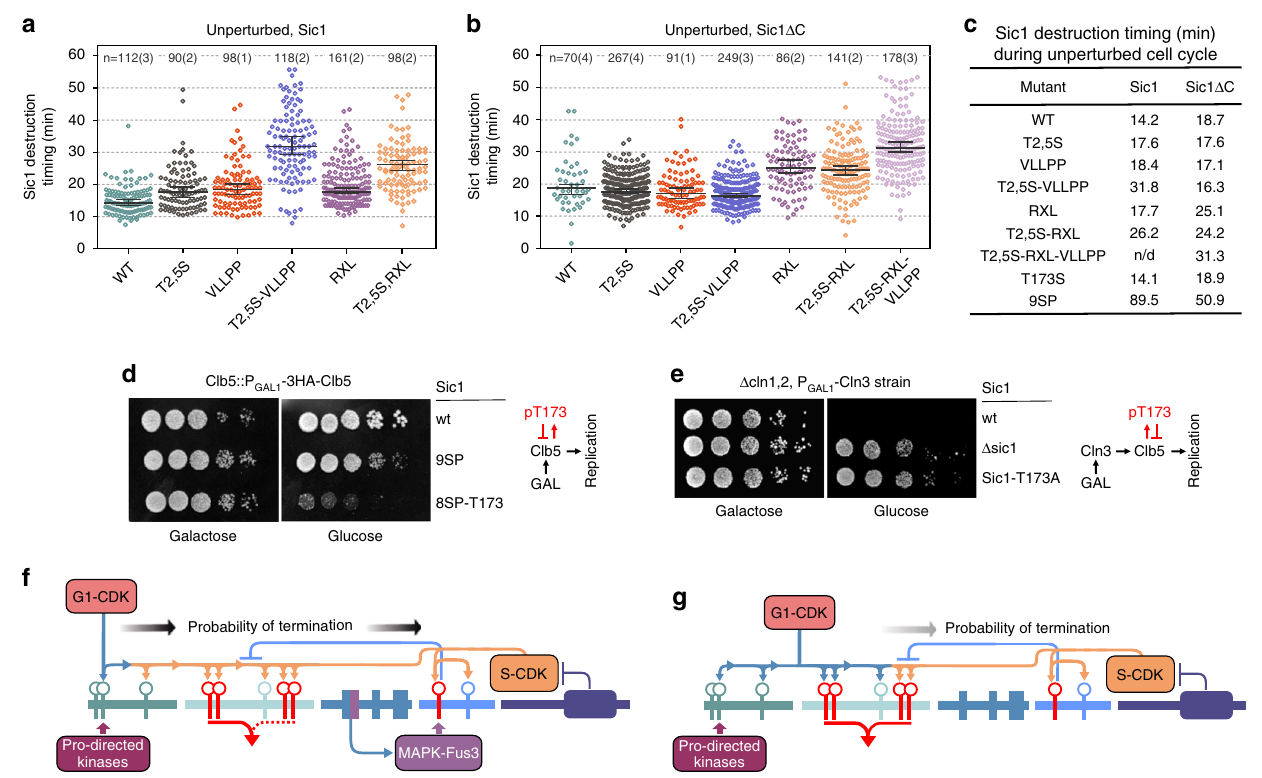
Fig. 6 The intracomplex phosphorylation connects G1-CDK priming and S-CDK activity. a , b Plots showing the distributions of Sic1 destruction timing values of individual cells in case of unperturbed cell cycle for strains expressing mutated variants of either full-length Sic1-EGFP in a or Sic1 Δ C-EGFP in b . In case of Sic1 Δ C-EGFP strains, endogenous Sic1 was expressed in the background. The median value along with 95% con fi dence intervals are denoted by black lines on the plot. The number of individual cells ( X ) observed over a number of individual colonies ( Y ) is given in form n = X ( Y ). The values for mother and daughter cells separately and the additional information are presented in Supplementary Table 1 and in the Source data fi le for Fig. 6. c A table of measured Sic1 destruction timing median values for the indicated strains. d A viability assay of strains with sic1::sic1(9SP) and sic1::sic1(8SP-T173) genomic replacements and conditional GAL1-CLB5 overexpression. e A viability assay of strains with sic1-deletion and sic1::sic1(T173A) genomic replacement in cln1,2-deletion background and conditional GAL1-CLN3 overexpression. The experiments for panels ‘ d ’ and ‘ e ’ were performed twice with similar result. f , g Schemes showing the difference in diversional termination mechanism for the borderline pheromone arrest ( f ), and for G1/S transition ( g ). Source data are provided as a Source Data fi le.